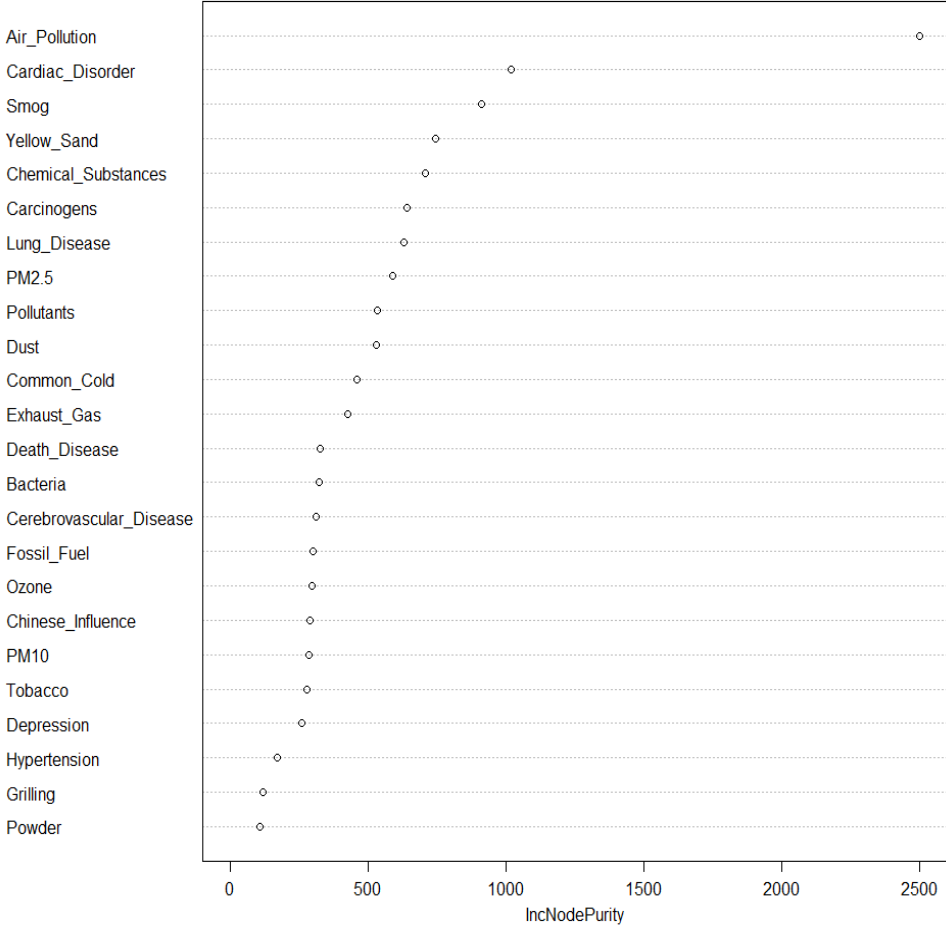
Figure 1. Random Forest Model of Cause-and-Disease Factor.